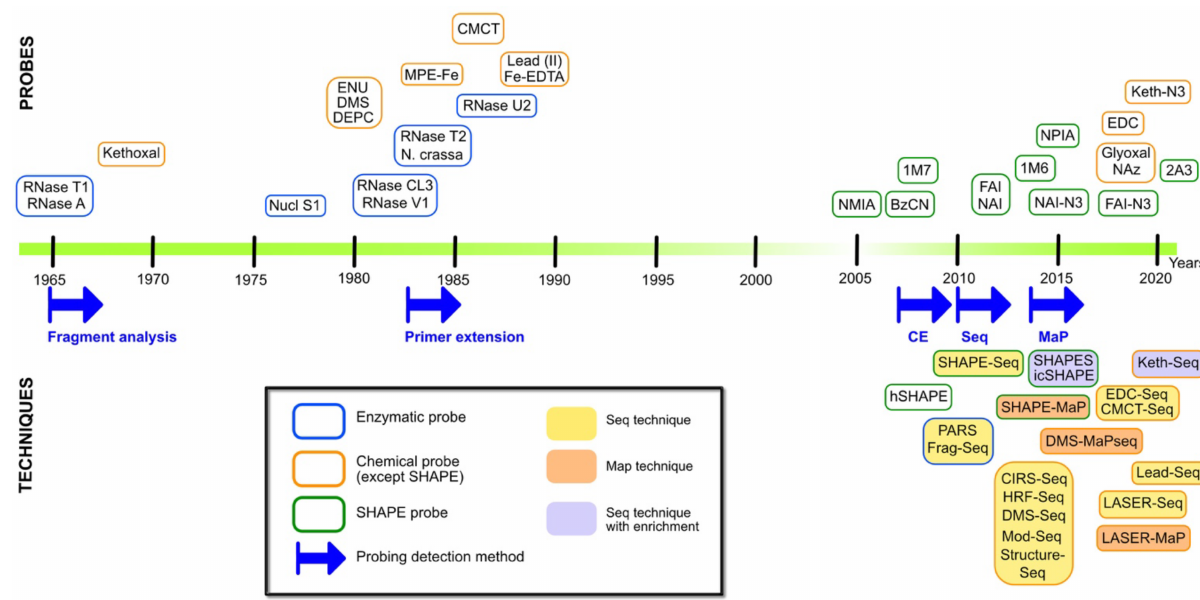
Figure 2. Timeline of RNA probes and probing techniques evolution. Upper part, enzymes are boxed in blue, chemical reagents (with the exception of SHAPE reagents) are boxed in orange, and SHAPE probes are boxed in green; the center of the box corresponds to the year of publication. Lower part, the blue arrows indicate the implementation of a new method to detect sites of cleavage or modification. CE: capillary electrophoresis; Seq: deep-sequencing; MaP: mutational profiling. Methods combining probing and deep-sequencing are highlighted in yellow. Methods based on mutational profiling are highlighted in orange, and techniques using enrichment by selection via the probe are labeled in purple. PARS: parallel analysis of RNA structure; FragSeq: fragmentation sequencing; CIRS-Seq: DMS and CMCT probing and sequencing; HRF-Seq: hydroxyl radical cleavage and sequencing; Mod-Seq: DMS probing and sequencing; Structure-Seq: DMS probing and sequencing; SHAPES: probing with NPIA and selection; icSHAPE: probing with NAI-N 3 and selection; Keth-seq: N 3 -kethoxal probing, selection, and sequencing; LASER/-seq/-MaP: light-activated structural examination of RNA/analyzed by sequencing/mutational